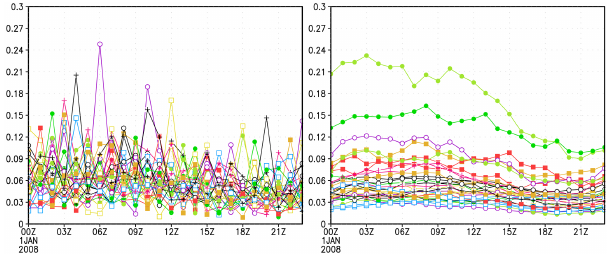
Figure 3. The ensembles of BC model simulation at grid 116.5 ◦ N, 40 ◦ E. The left one uses sample strategy with no time correlation. The right one uses sample strategy with time correlation α = 0 . 9. The red points is the daily variation of BC observations (units: µgm − 3